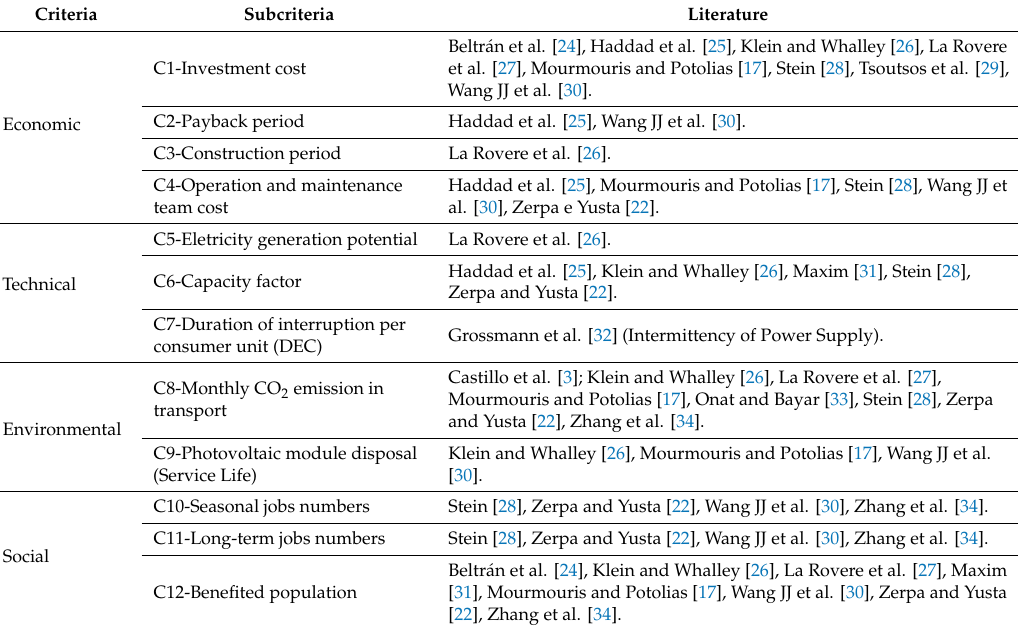
Table 5. Enterprise or business